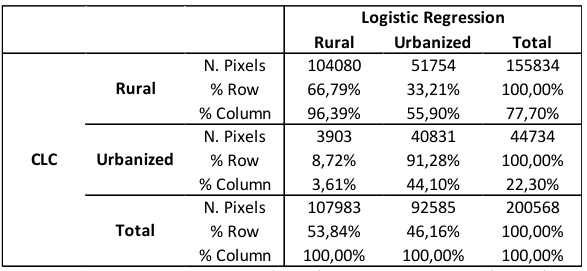
Table 1. Urbanized Land (CLC) vs Black Marble (MRB) Black Marble, with a pixel depth of 16 bits, and a spatial resolution of 0.0066667901 degrees (compared to 8 bits and 0.0083333333 of DMSP-OLS) obtains results that can be